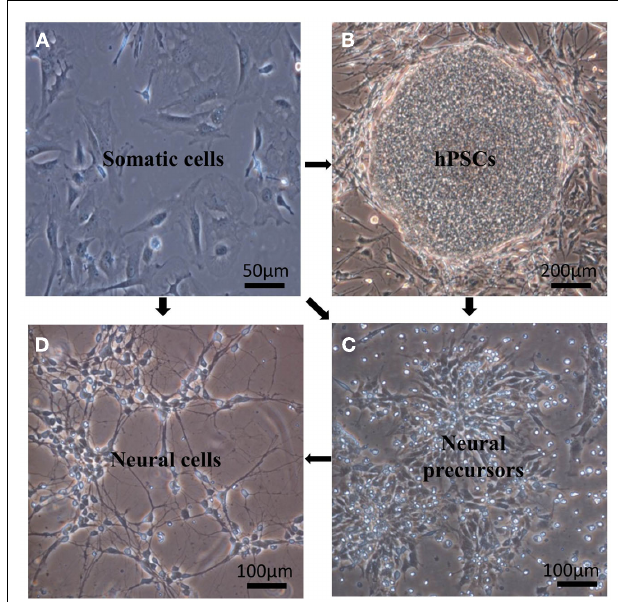
FIGURE 1 | Generation of neural precursors or neural cells from pluripotent stem cells using differentiation or somatic cells using transdifferentiation. ( A ) Fibroblasts used for direct reprogramming using the four transcription factors: Oct4, Sox2, KLF4, c-Myc. ( B ) hESC, H1 cell line cultured on mouse embryonic fibroblasts as feeder cells (MEFs). ( C ) Neural precursor cells obtained from differentiated H1. ( D ) Monolayer of neurons differentiated from